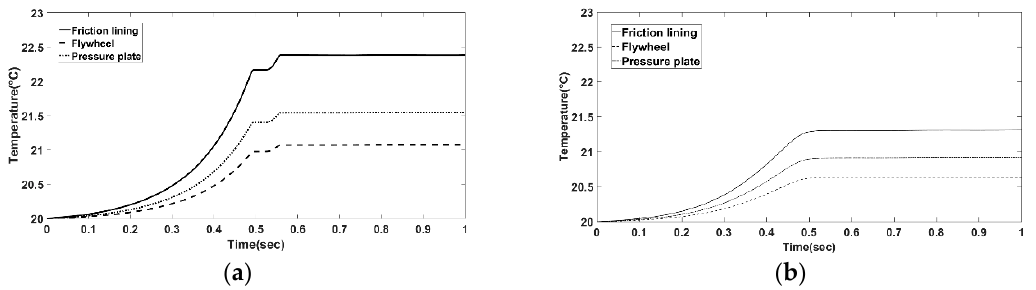
Figure 7. Predicted clutch system temperature rises for a single engagement for ( a ) new and ( b ) worn friction linings.